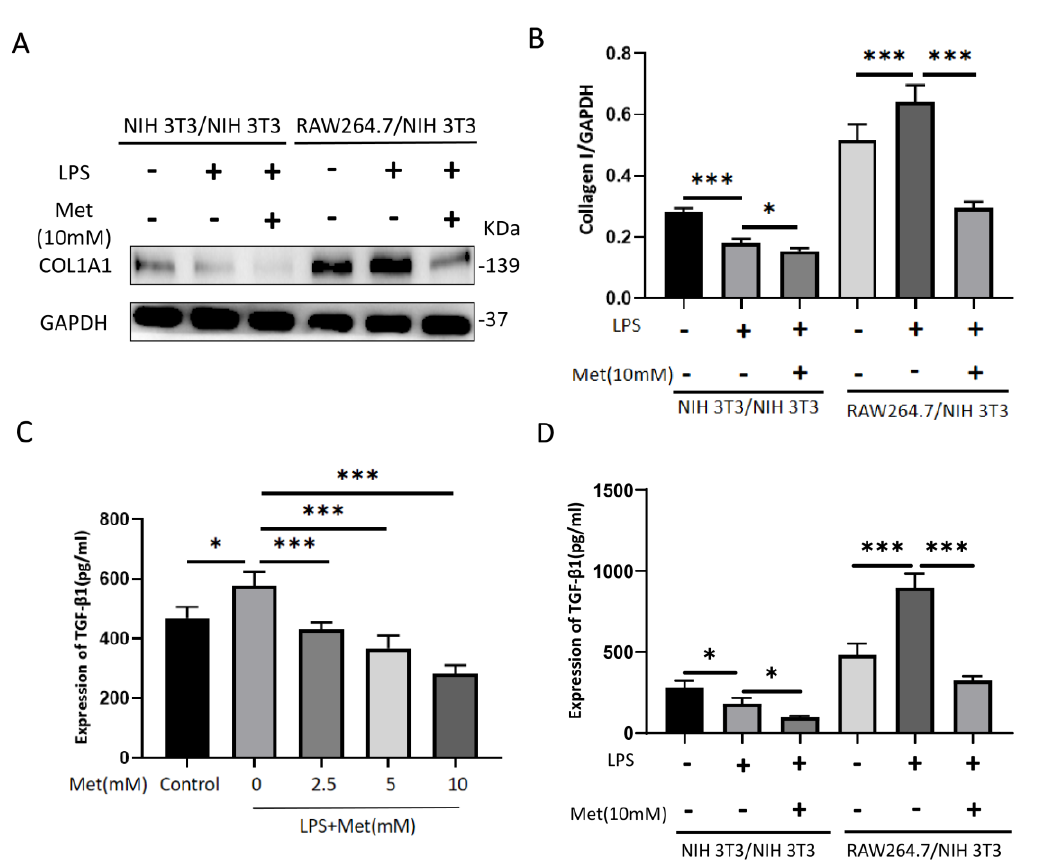
Figure 9. Metformin inhibits the expression of collagen I in NIH 3T3 cells in a co − culture system by suppressing TGF − β 1 paracrine secretion in RAW 264.7 cells. ( A , B ) Representative Western blot bands of collagen I in each co − culture group. GAPDH was used as a loading control. Semiquantitative analysis of the expression of collagen I in each group. ( C ) ELISA assay of TGF − β 1 expression in RAW 264.7 cells after 6 h of LPS (1 μg/mL) stimulation with or without different concentrations of metformin (0 − 10 mM) pretreatment for 18 h. ( D ) ELISA assay was performed to detect the expres- sion of TGF −β1 in each cell co − culture group. Data indicate means ± SDs of three independent ex- periments. * p < 0.0 5 and *** p < 0.001. NIH 3T3/NIH 3T3 (LPS − Met − ): NIH 3T3 cells and NIH 3T3 cells were co − cultured for 48 h without LPS or Met, NIH 3T3/NIH 3T3 (LPS+ Met − ): NIH 3T3 cells and NIH 3T3 cells were co −cultured for 48 h with 1μg/mL of LPS, NIH 3T3/NIH 3T3 (LPS+ Met+): NIH 3T3 cells and NIH 3T3 cells were co −cultured for 48 h with 1 μg/mL of LPS and 10 mM of Met, RAW 264.7/NIH 3T3 (LPS − Met − ): RAW 264.7 cells and NIH 3T3 cells were co − cultured for 48 h without LPS and Met, RAW 264.7/NIH 3T3 (LPS+ Met − ): RAW 264.7 cells and NIH 3T3 cells were co −cultured for 48 h with 1 μg/mL of LPS, RAW 264.7/NIH 3T3 (LPS+ Met+): RAW 264.7 cells and NIH 3T3 cells were co − cultured for 4 8 h with 1 μg/mL of LPS and 10 mM of Met.